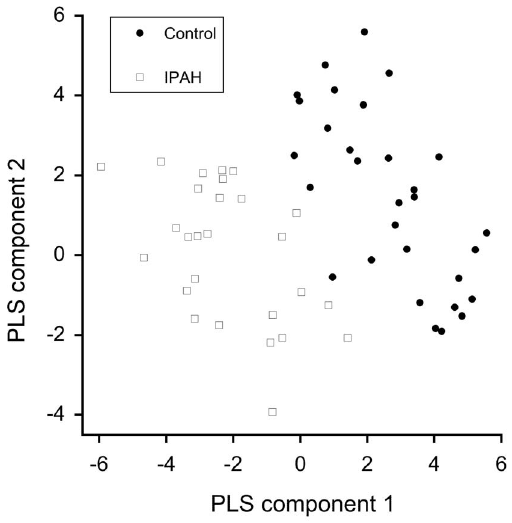
Figure 2. Plot of the results of autoregression and partial least squares analysis-weighted components of control subjects (dark circles) and IPAH subjects (open squares). 22 out of 27 disease (positive) samples were confirmed as positive (sensitivity =81.5%) and 21 out of 30 control (negative) samples were confirmed as negative (specificity =70.0%). The positive likelihood ratio was 2.76 while the negative likelihood ratio was 0.368.